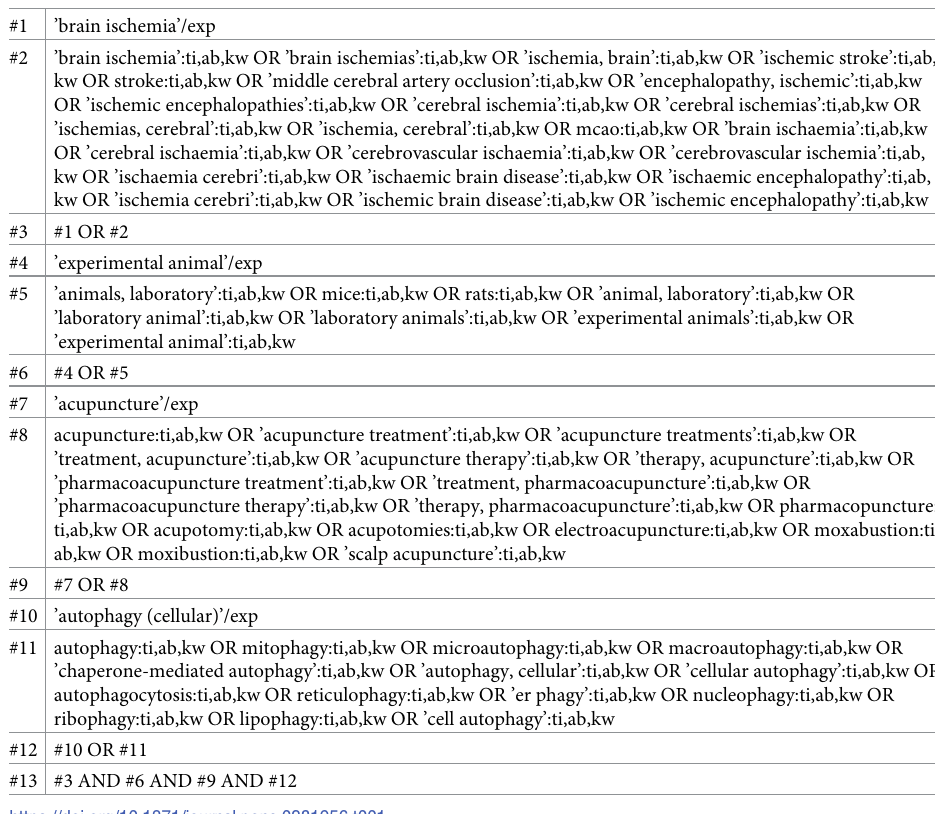
Table 1. Example of a search strategy for